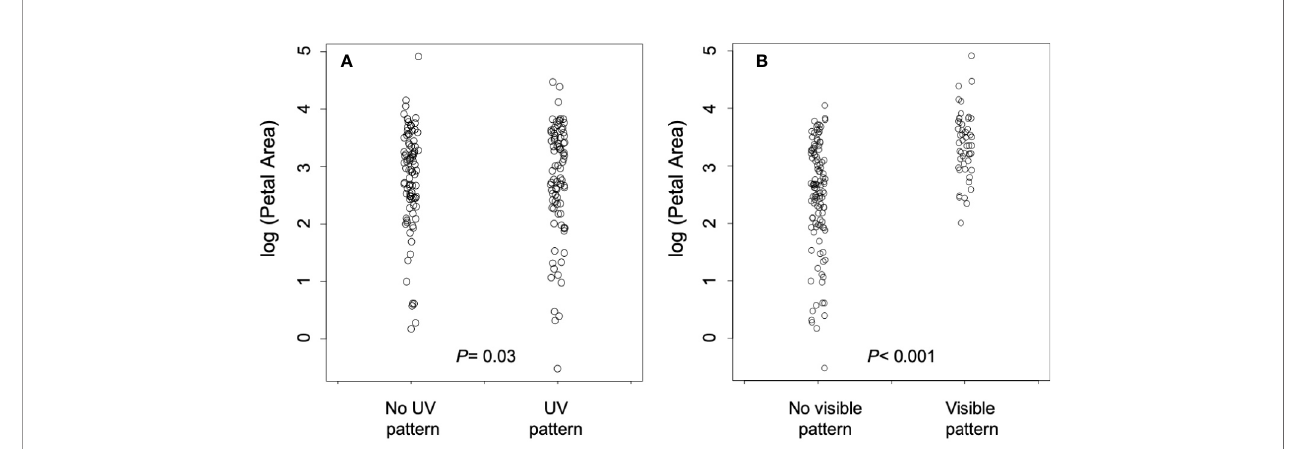
FIGURE 3 | (A) The relationship between petal area and the presence/absence of UV pigmentation pattern. (B) The relationship between petal area and the presence/absence of human-visible pigmentation pattern. P values in each panel are from phylogenetically controlled generalized estimating equations testing the association between the presence of pattern and fl ower